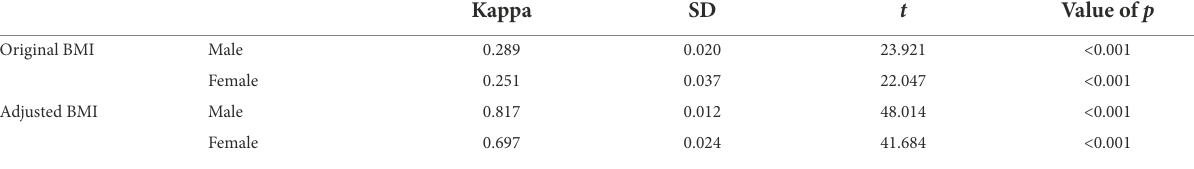
TABLE 6 Kappa statistics of original and adjusted BMI cutoff points.